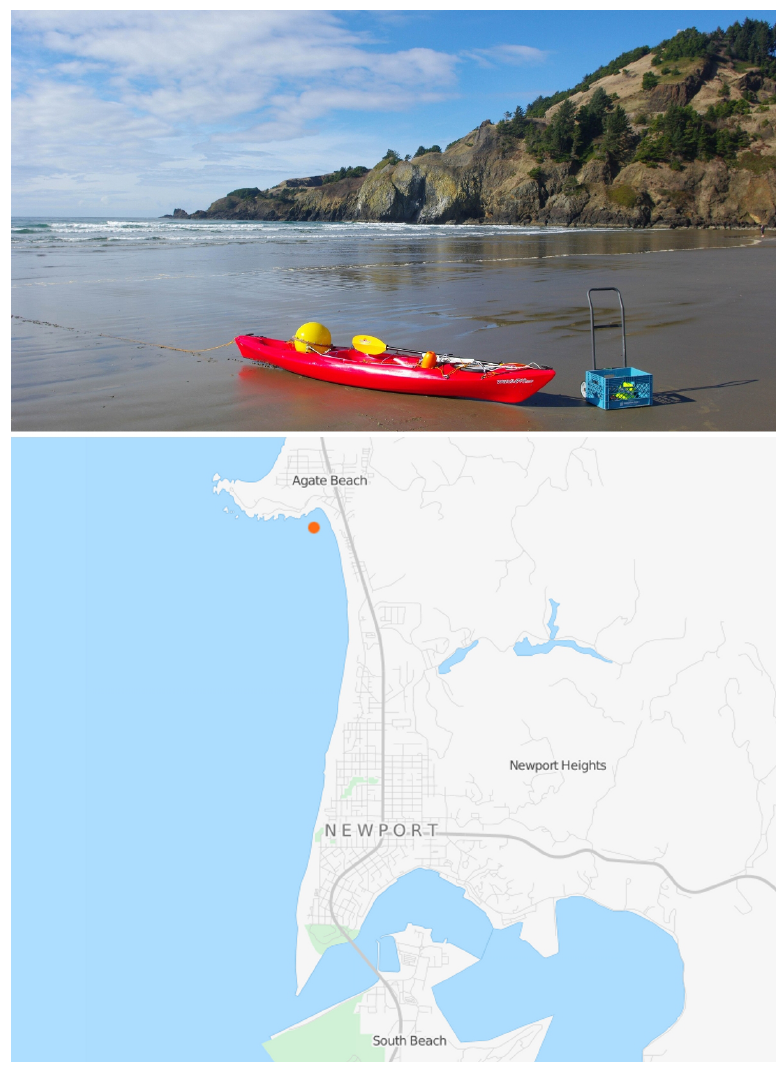
Figure 4. ( Top ) The buoy is tied down in the kayak prior to deployment with Yaquina Head in the background. ( Bottom ) The approximate deployment location off Agate Beach, OR is marked with an orange